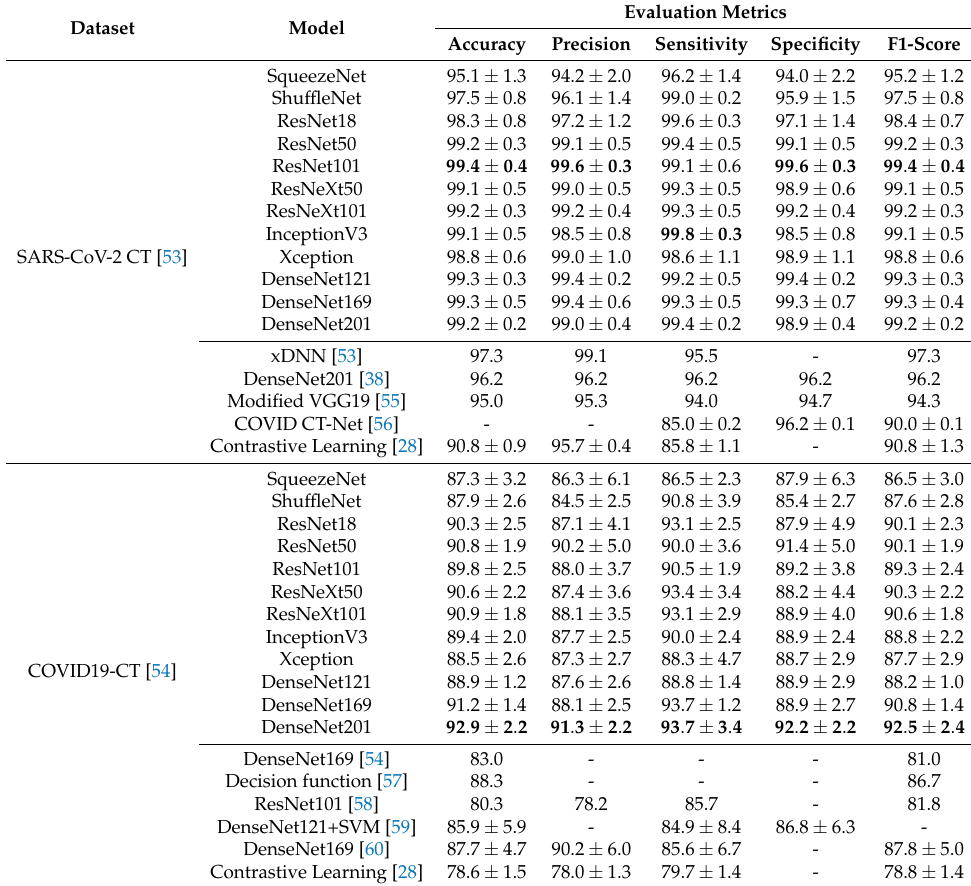
Table 2. Performance comparison of different deep models for detecting COVID-19 using various evaluation metrics. The results are given in the form of mean and standard deviation scores. For a direct comparison, the results from the recently published work are included when